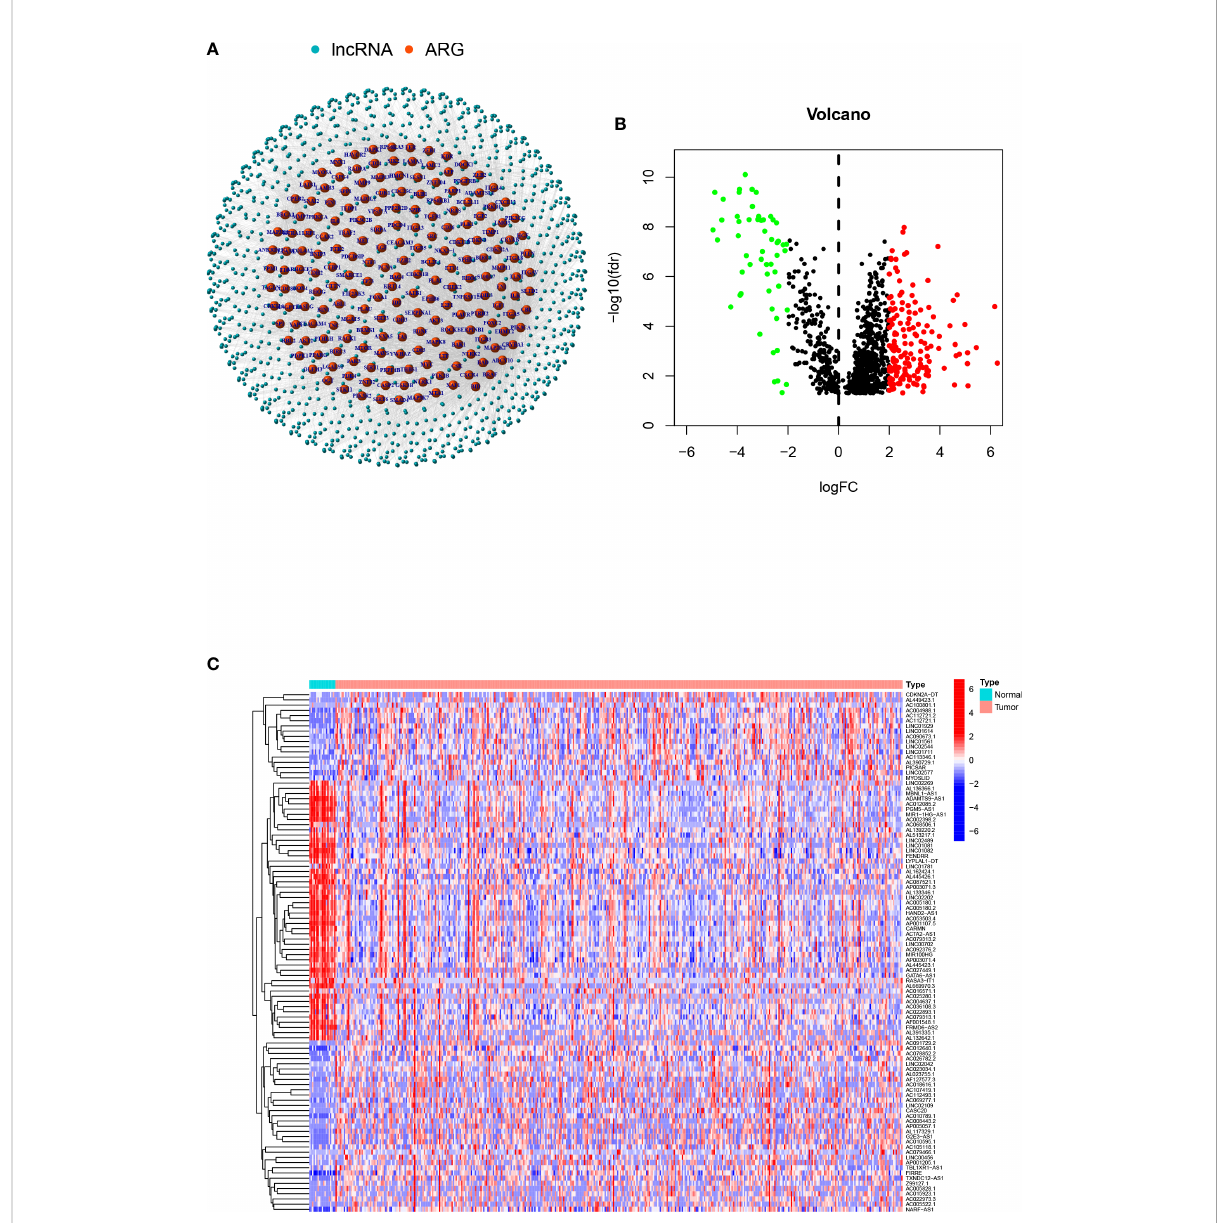
FIGURE 1 arlncRNAs identi fi cation and expression in bladder cancer: (A) arlncRNAs-ARGS network diagram; (B) Volcano plot of Log2 fold change (FC)>2 differentially-expressed ARGs; (C) Volcano plot of 101 arlncRNAs in normal and tumor